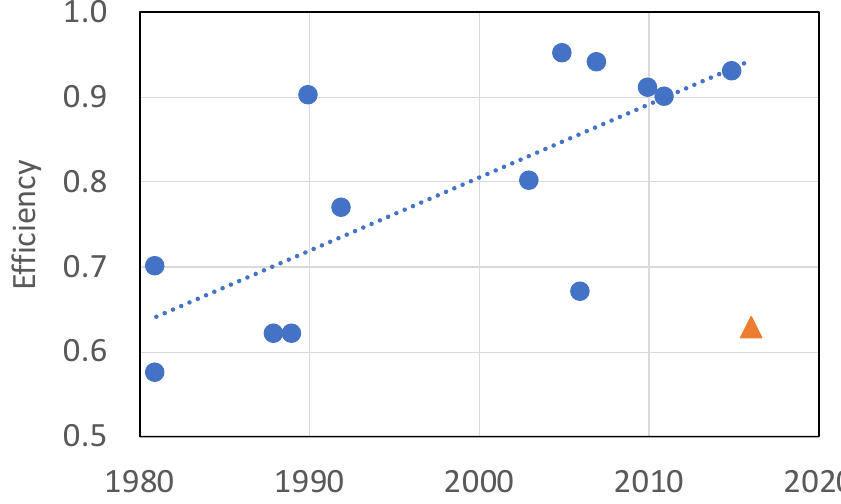
Figure 1. Increase in the literature-based seepage meter efficiency determined by relating measured versus known seepage rates in a calibration tank [3,5–7,12,15,19,24–28]. Orange triangle symbol is from Solder et al. [29].